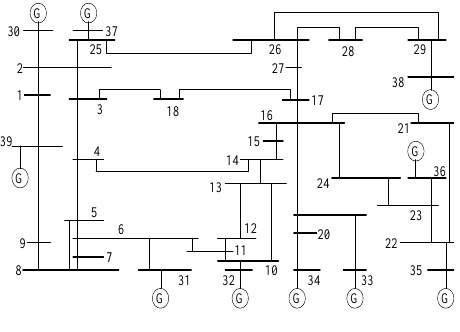
Figure 4 IEEE 39-bus system is taken as an example for PMU configuration.